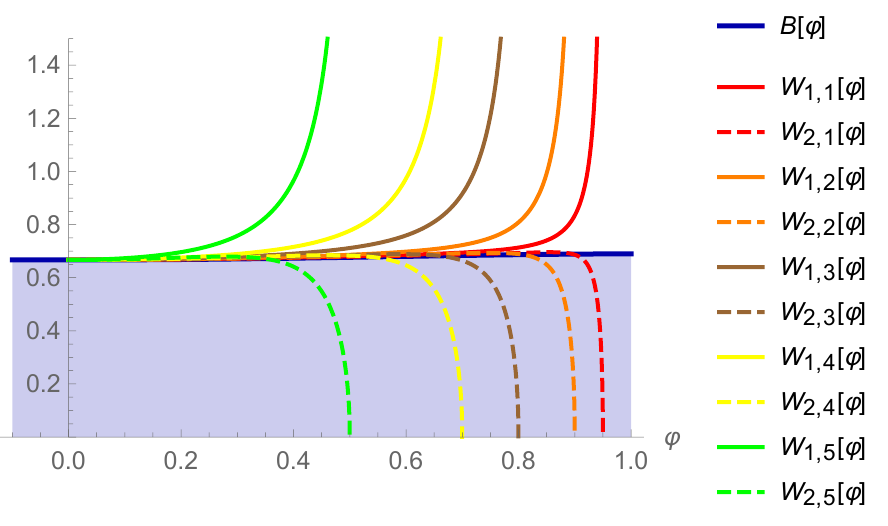
Figure 11 . Solutions W 1 ( ’ ) and W 2 ( ’ ) for the potential (8.1) with (cid:1) (cid:0) = 1 : 2 in the case where the sphere 1 shrinks. The (cid:12)ve solutions ( W 1 ;i ; W 2 ;i ) with i = 1 ; : : : ; 5 di(cid:11)er in the value of their IR endpoint ’ 0 for T 2 ; 0 ‘ 2 = 4 : 5. The critical curve is de(cid:12)ned as B ( ’ ) (cid:17) S 4 [21], the superpotential W ( ’ ) cannot enter the area below the critical curve, which is depicted as the shaded